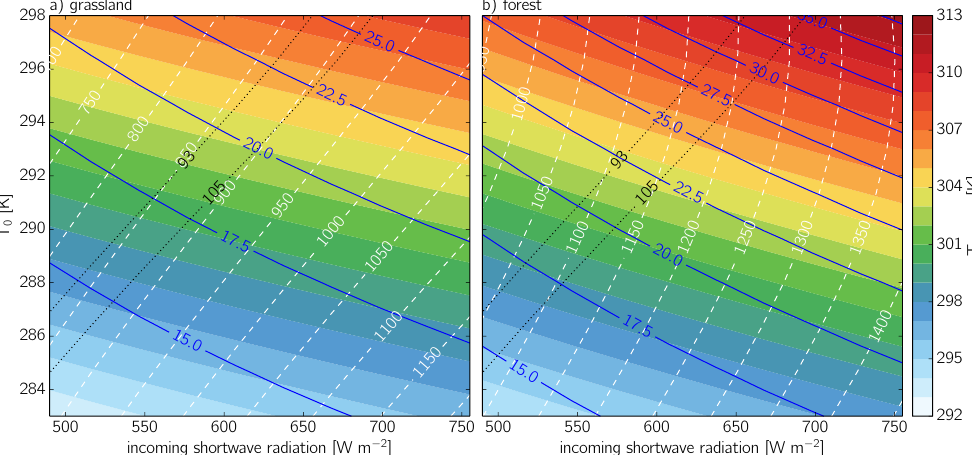
Figure 5. Maximum temperatures (color band), vapor pressure deficit (blue solid lines) and boundary layer height (white dashed lines). The values for the VPD (hPa) and the boundary layer height (m) are the 10h means over the entire duration of the model run, and the maximum 2m temperature is the maximum over the duration. The black dotted lines correspond to the range in which grassland gives a constant sensible heat flux with similar magnitudes as those in the observations in Fig.